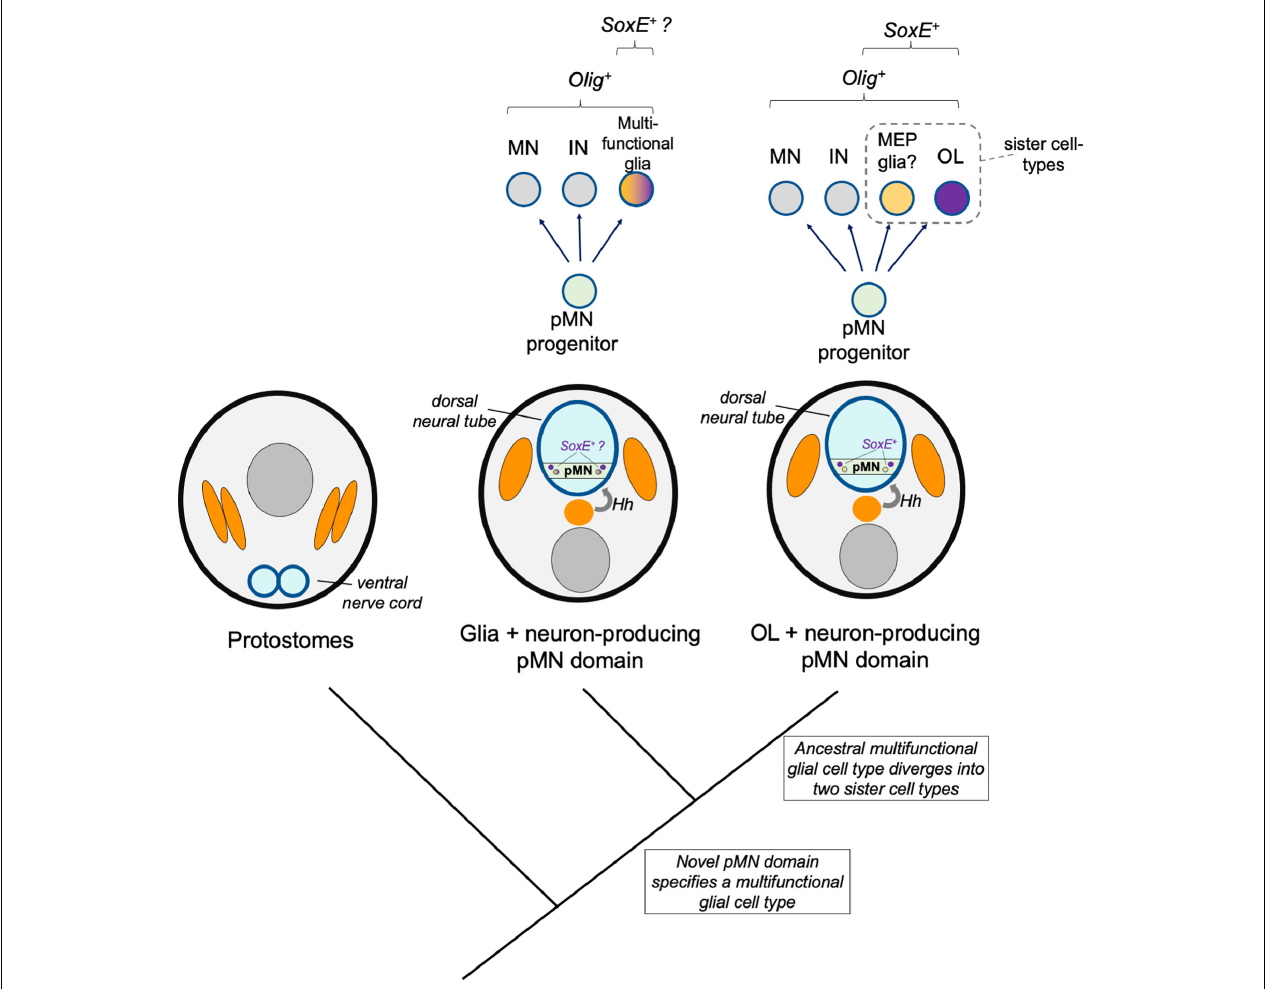
FIGURE 4 | Sister cell type model. A hypothetical model shows a multi-functional pMN-derived glial cell type (orange–purple) that through duplication led to two novel cell types that diverged and specialized, including oligodendrocytes (OL, purple). A sister cell type to oligodendrocytes may be MEP glia, which also derive from Olig-expressing pMN progenitors, express SoxE factors, and myelinate motor axons in the